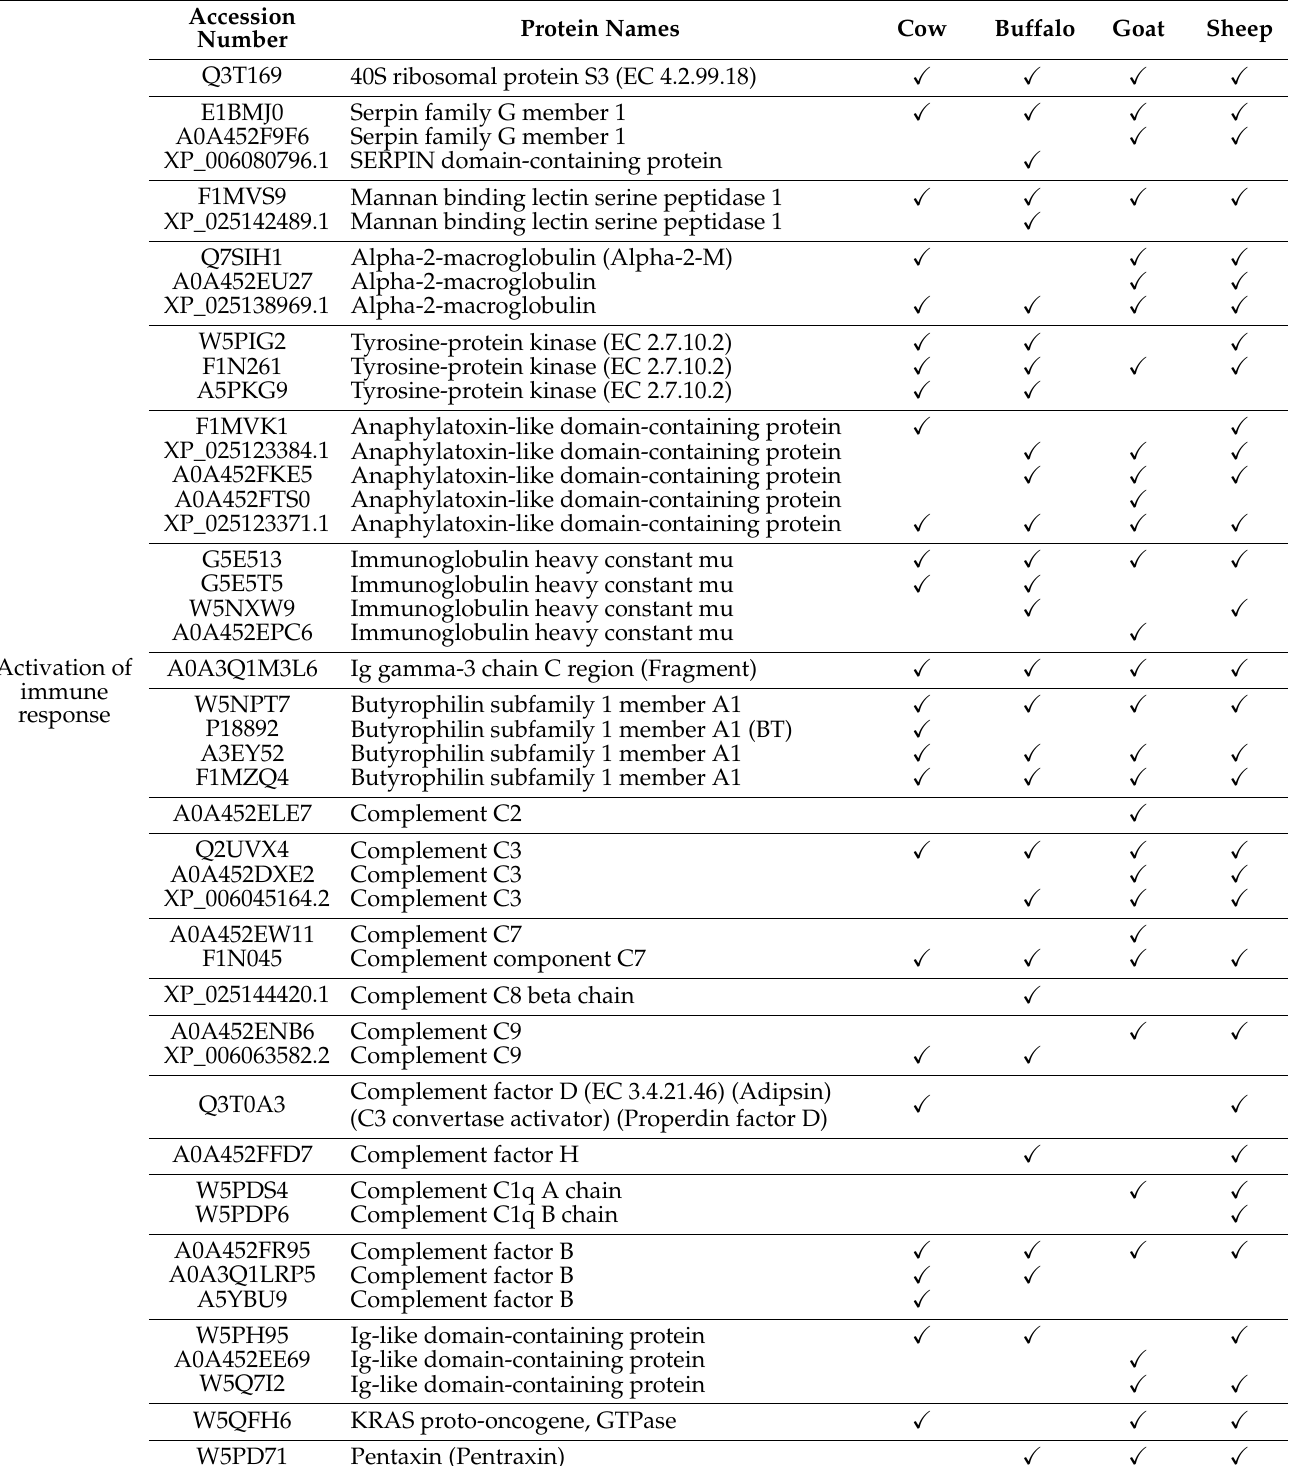
Table 3. Proteins identified in cow, buffalo, goat and sheep cream in the biological process GO terms “Activation of immune